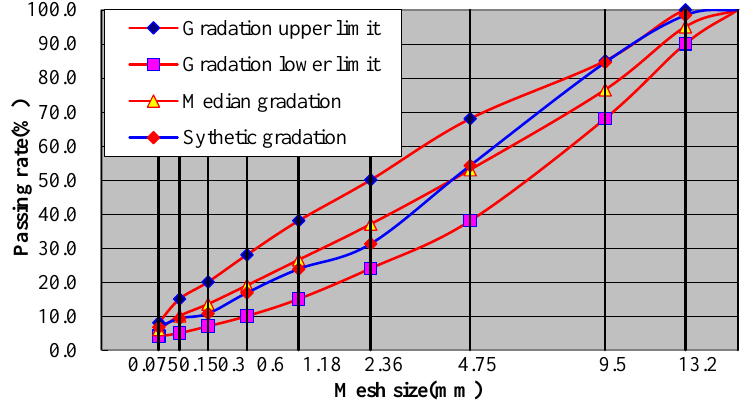
Figure 2. AC-13 design grading curve.